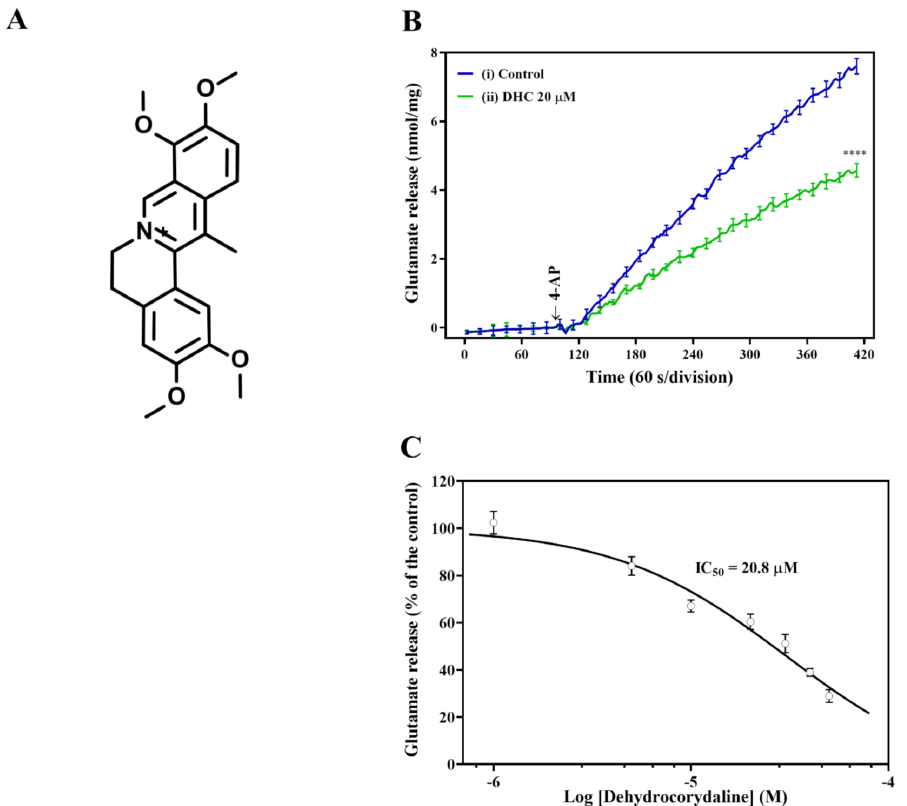
Figure 1. Influence of DHC on 4-AP-evoked glutamate release. ( A ) Chemical structure of DHC. ( B ) DHC (20 µ M) inhibited glutamate release evoked by 4-AP depolarization. Rat brain cortical synaptosomes were depolarized with 15 mM KCl, and the continuous release of glutamate followed. Representative traces of continuous glutamate release curves after treatment with DHC in the presence of 1 mM 4-AP. ( C ) The dose-dependent response of DHC to glutamate release. Rat synaptosomes were preincubated for 10 min in the presence of DHC, followed by the addition of 4-AP. Data were analyzed with Prism 8.4.3 using nonlinear regression. The results are expressed as the mean ± SEM ( n = 5). **** p < 0.0001 versus the control